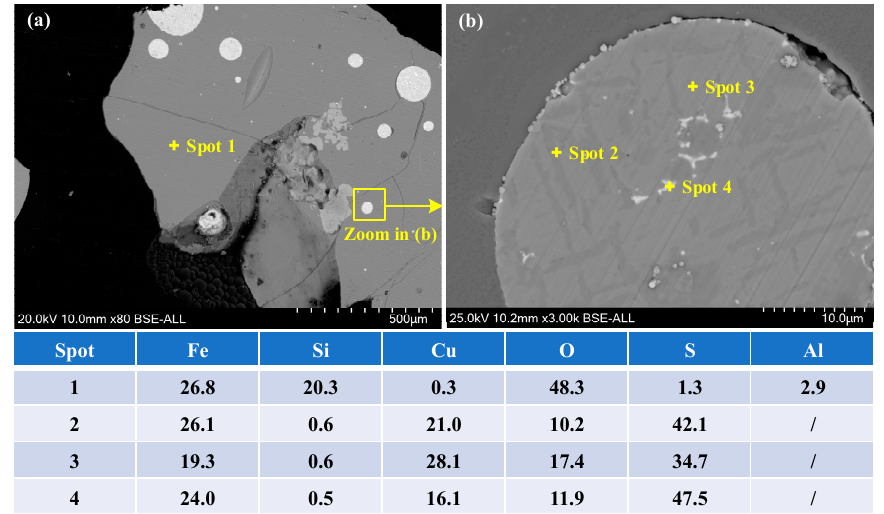
Figure 1. SEM-EDS analysis of copper slag ( a ) SEM in 80 times; ( b ) SEM in 3000 times.